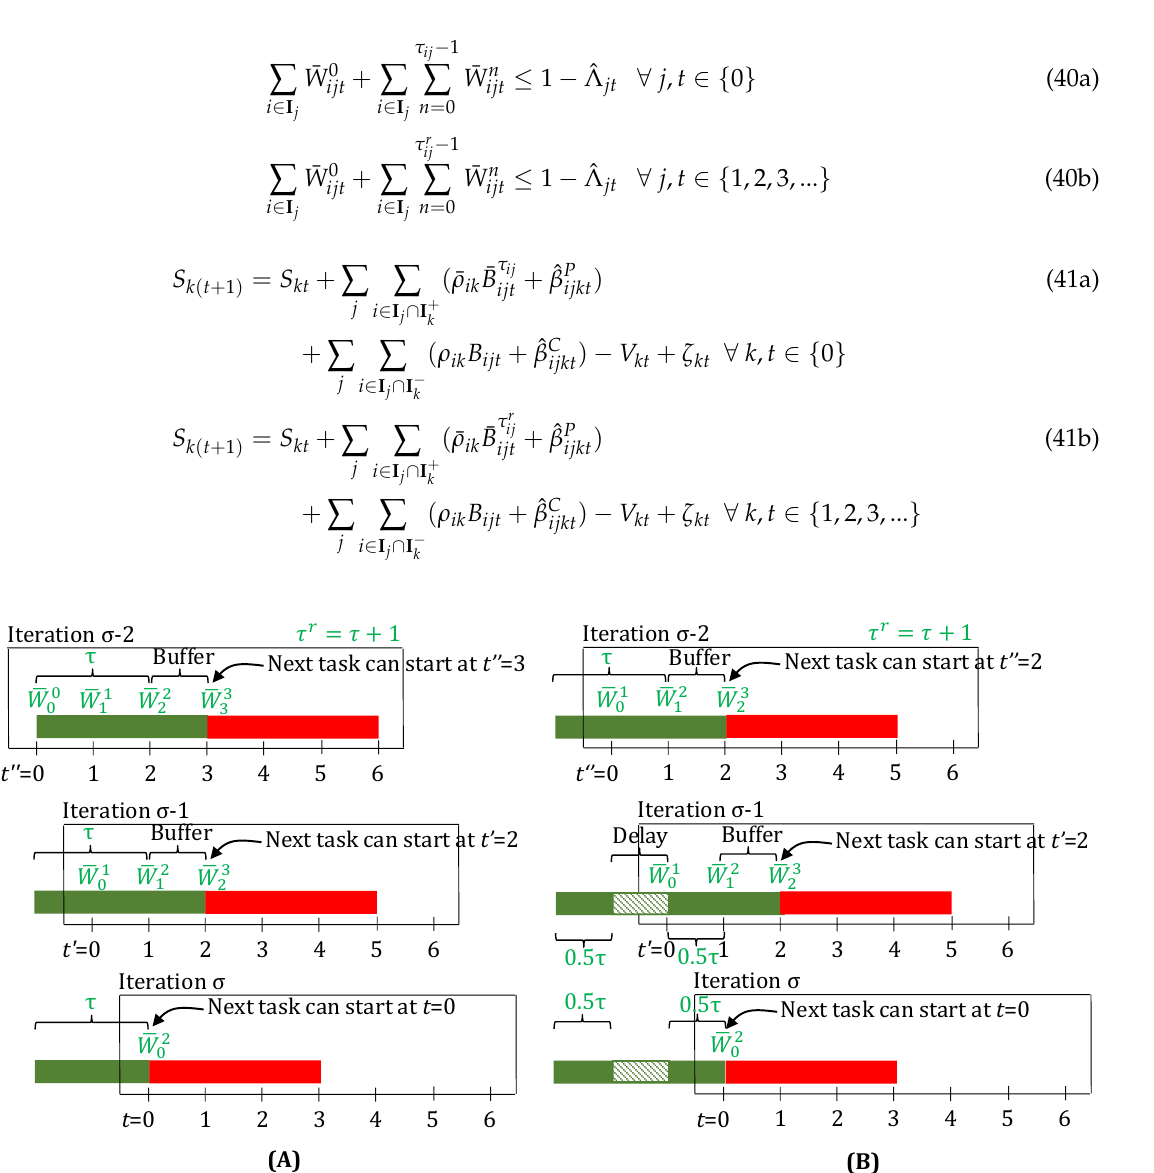
Figure 9. For the green task ( τ = 2), a delay buffer of 1 h is chosen, i.e., τ r σ − 1, the model predicts that the green task will finish at t (cid:48) = 2. In the next iteration σ , when there is no delay in the green task, having run for 2 h, it correctly finishes at t = 0. No ad-hoc model changes are required in between the iterations to make this possible. Consequently, to take advantage of this nominal finish time of the green task, the red task, now starts 1 h earlier than what it was scheduled for in the previous iteration. ( B ) The green task, with conservative processing time, is scheduled to finish at t (cid:48)(cid:48) = 2 in iteration σ − 2. In iteration σ − 1, a delay of 1 h is observed. The processing time delay buffer is maintained, and now the task is anticipated to finish at t (cid:48) = 2. In the next iteration ( σ ), the task correctly finishes at t = 0, accounting for the 1 h delay. The red task can now start on time at t = 0, or equivalently t (cid:48)(cid:48) = 2. Thus, having a delay buffer was useful, since it predicted a realistic start time for the red task in iteration σ − 2